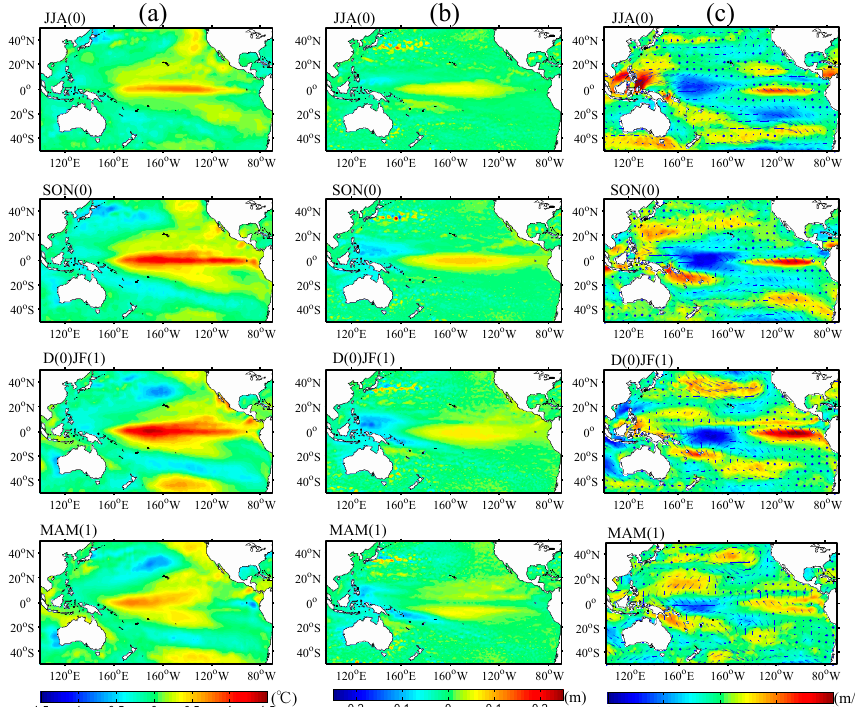
Figure 6. Seasonally evolving patterns of ( a ) SST; ( b ) sea level; and ( c ) SSW anomalies from JJA(0) to MAM(1) regressed with the PC of the first SEOF mode of precipitation.